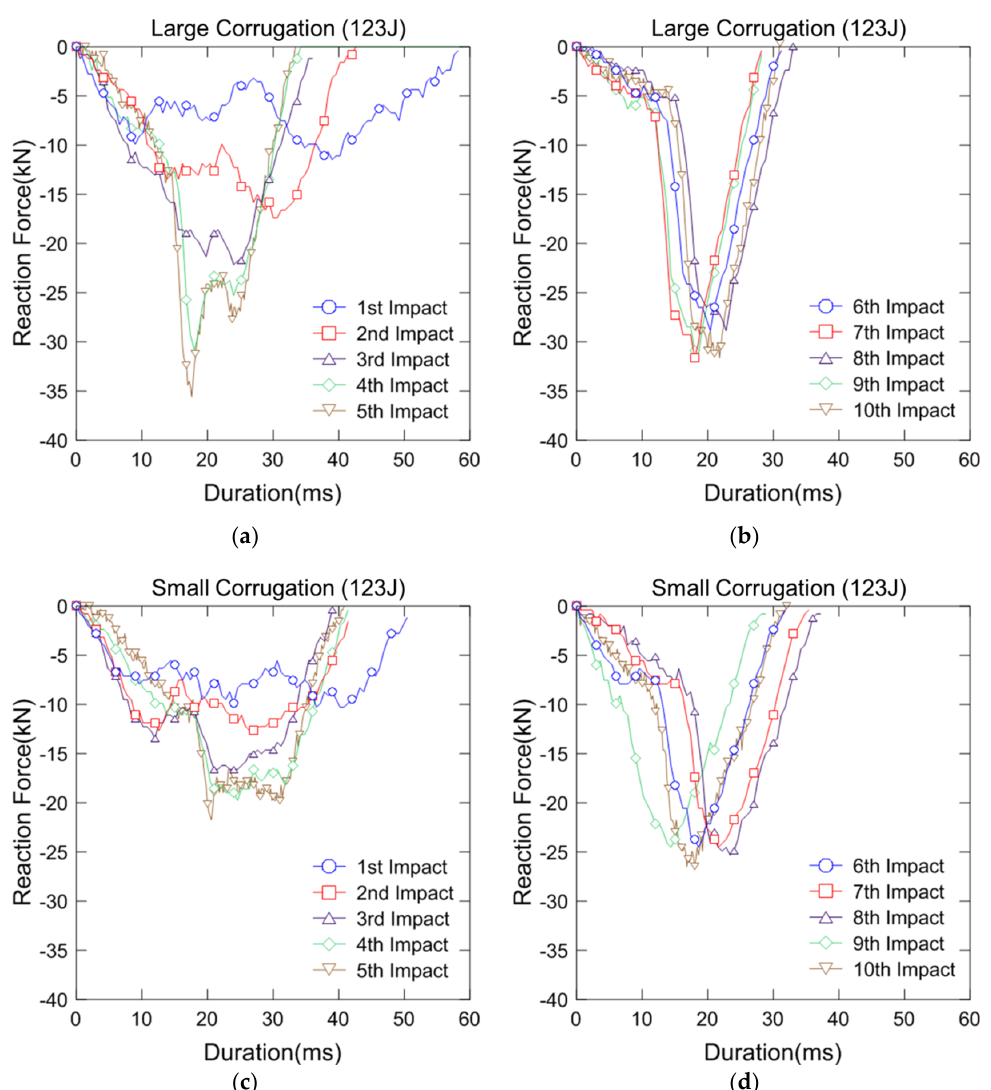
Figure 8. Reaction force time history of L123 scenario ( a ) from the first to the fifth impact loading and ( b ) from the sixth to tenth impact loading, and S123 scenario ( c ) from the first to the fifth impact loading and ( d ) from the sixth to tenth impact loading.